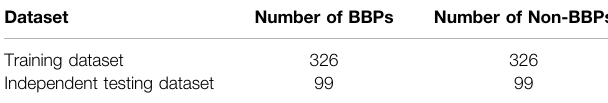
TABLE 1 | List of training dataset and independent testing